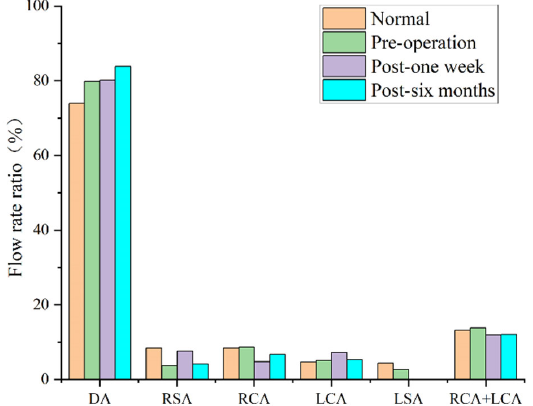
Figure 5. Average perfusion rate of each outlet within one pulsation cycle .